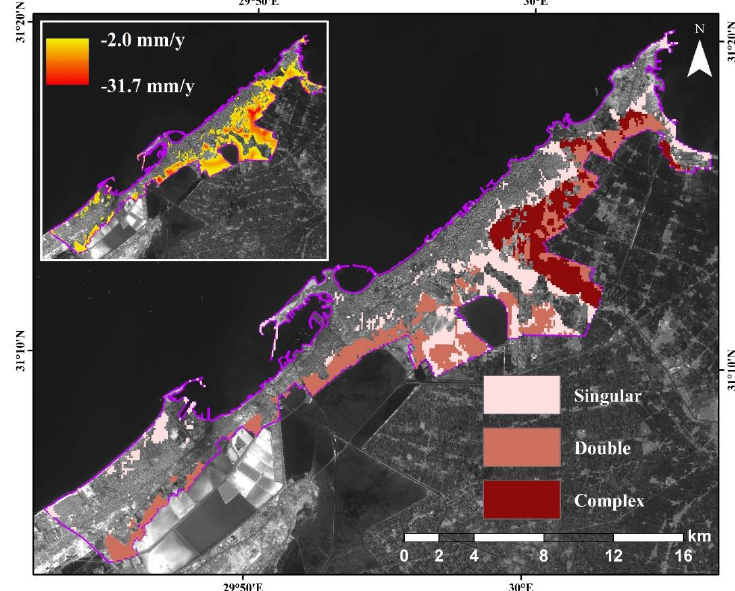
Figure 12. Complex subsidence causality map of Alexandria presented on the Sentinel-2 gray image of 24 October 2018 blue band; the insert map shows corresponding annual subsidence velocity during the study period.